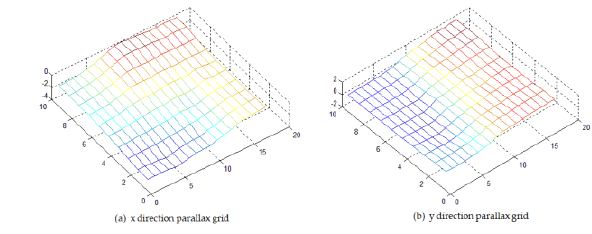
Figure 4. parallax grid results